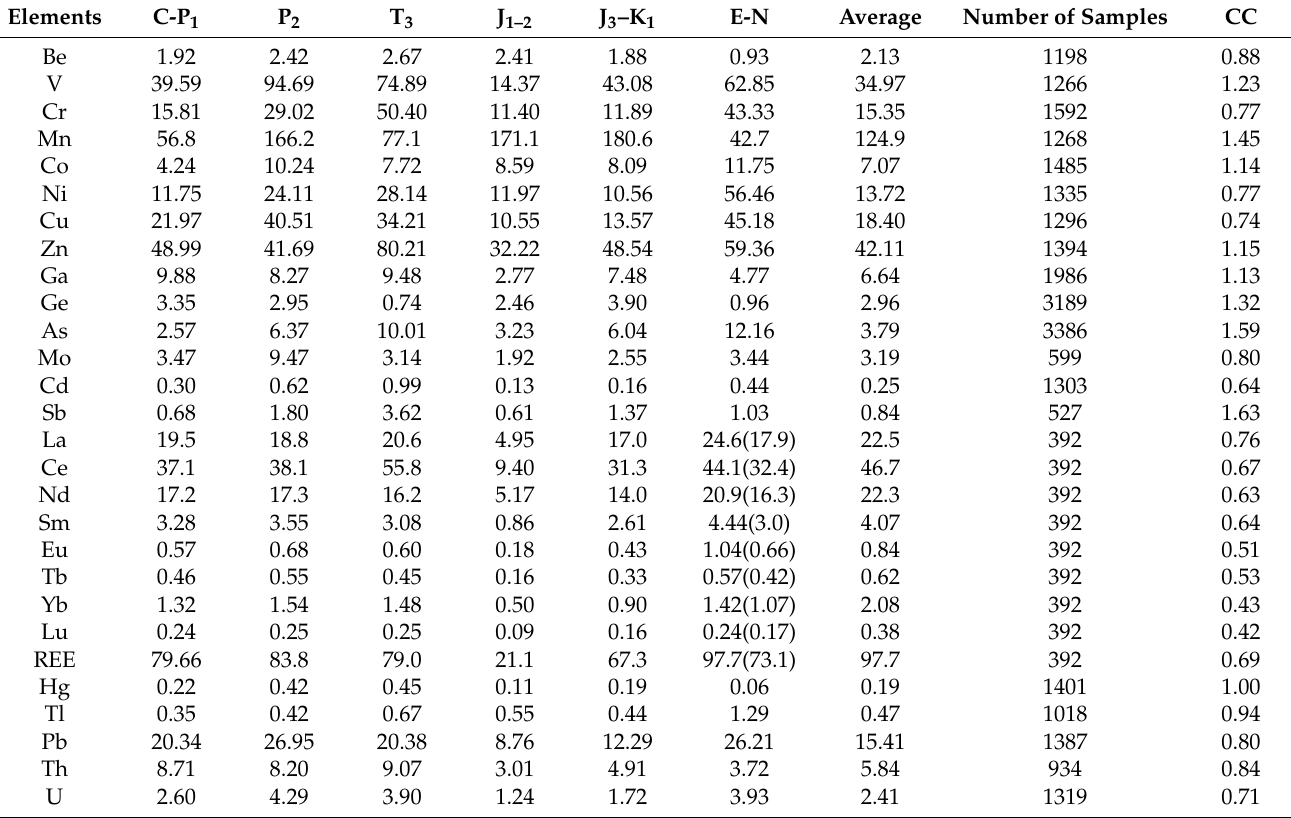
Table 6. The average concentration of elements in coals from different coal-forming periods in China (ppm, on a whole-coal